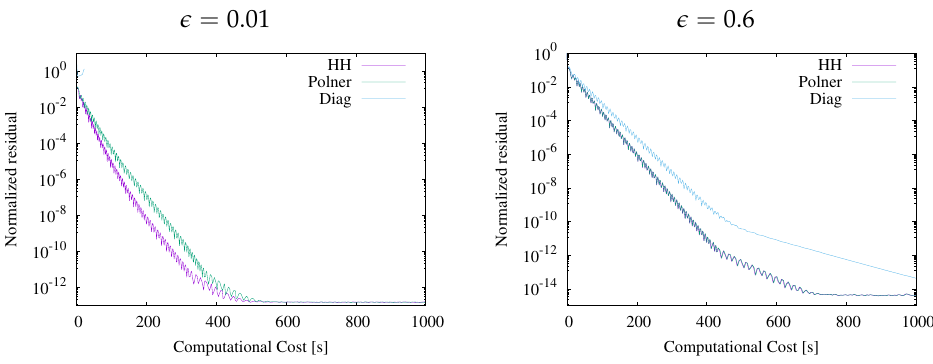
Figure 3. Buoyancy-driven square cavity. Boussinesq model with SUPG. Residual convergence for various stabilization